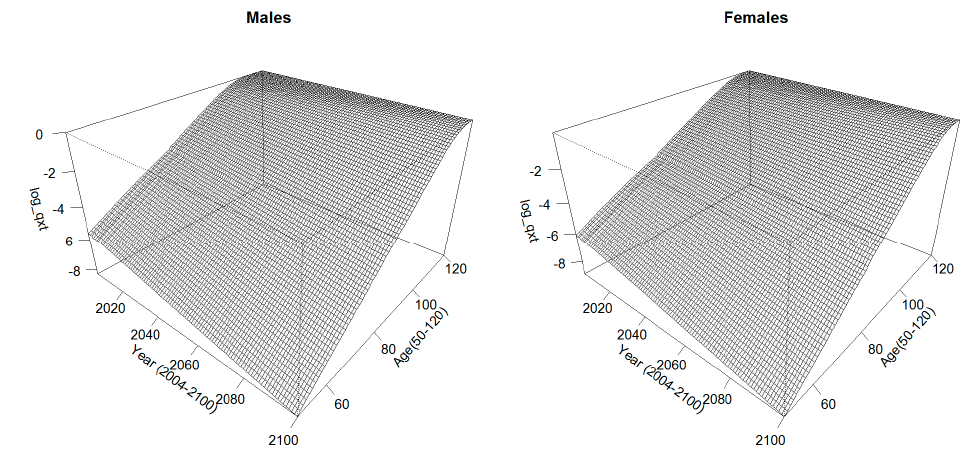
Figure 15. Experience mortality surface (ASMRs) projected till 2100 for males and females and extended to the ages beyond 80 until 120 years old.